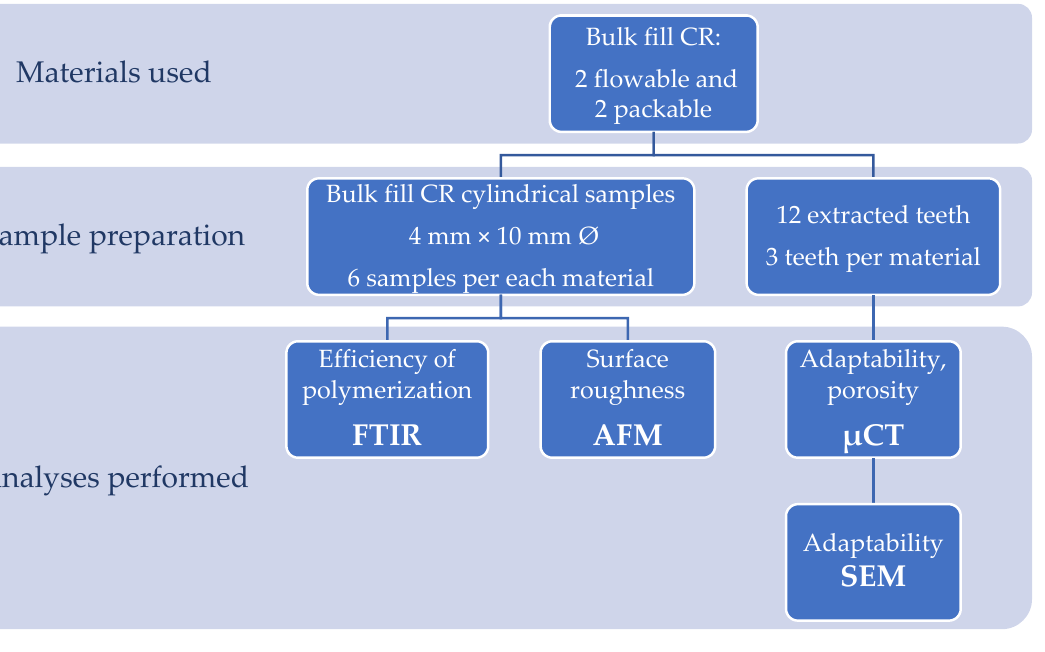
Figure 1. Study design.